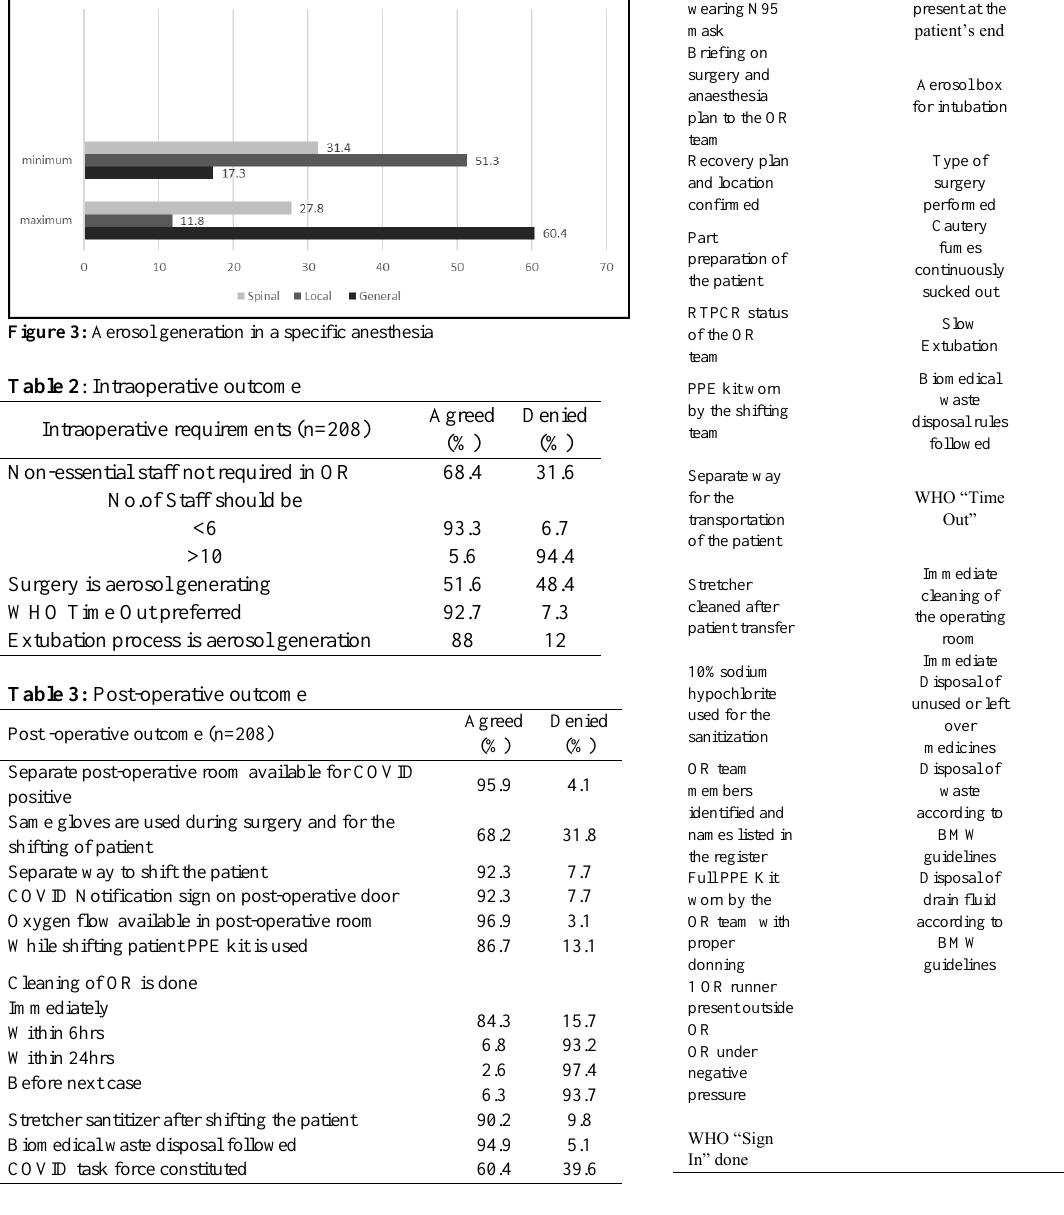
Figure 2: Sanitization products used